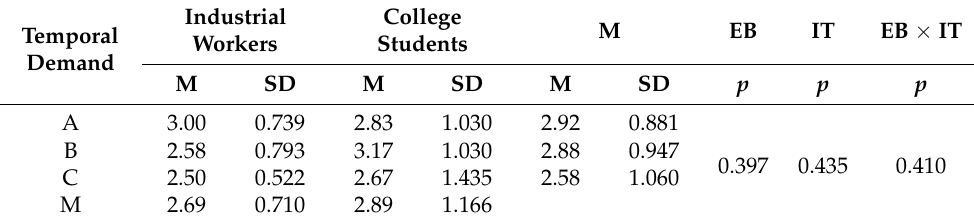
Table 7. Descriptive statistics and two-way ANOVA on the temporal demand by NASA-TLX.